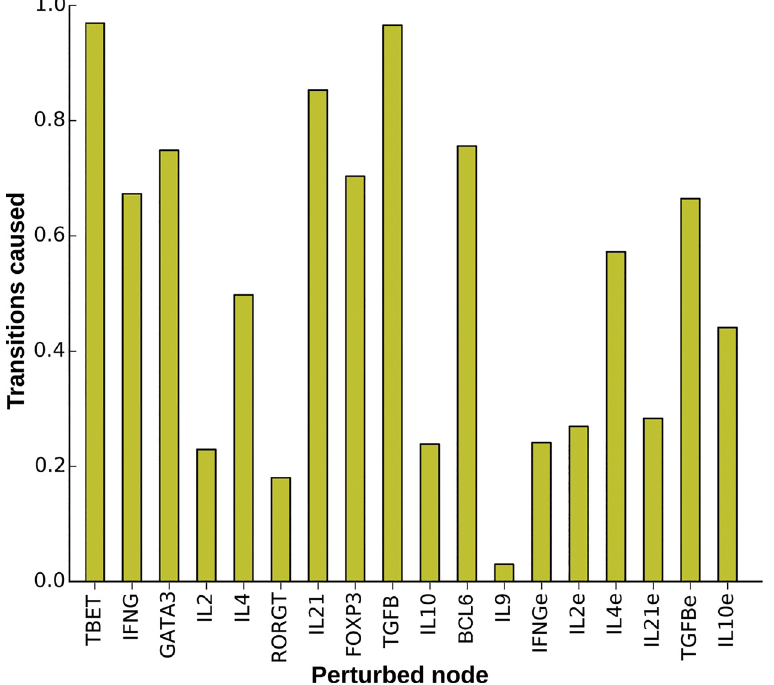
Fig 7. Role of different network nodes in the plasticity of the TSRN model. The proportion of transitions between attractors in response to transient perturbations in the value of each node. On average, 37.76% of the perturbations result in transitions to another cell type, with 47.12% of perturbations of intrinsic components resulting in transitions, compared with 24.43% of perturbations of extrinsic cytokines.